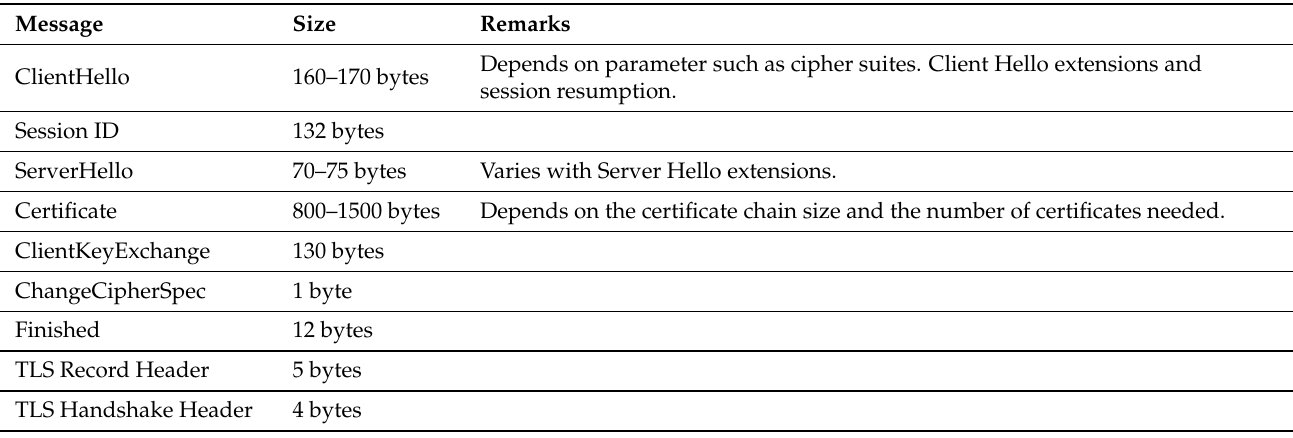
Table 5. Message sizes of TLS.